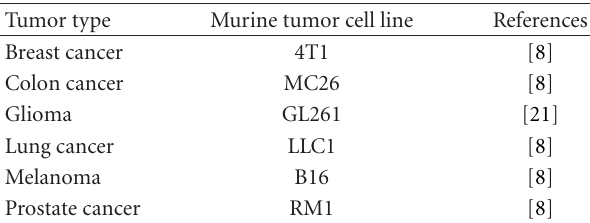
Figure 1: TLR4/MD-2 receptor complex recognizes and binds endotoxin. (a) MD-2 (shown in blue ribbons) is a soluble protein with a large hydrophobic pocket that directly binds bacterial endo- toxin (red). One of the acyl chains of endotoxin (yellow) remains outside the hydrophobic pocket and mediates crucial interactions with TLR4 that bind the TLR4/MD-2 heterodimer together. Left: direct view of the MD-2 hydrophobic pocket. Right: side view showing the protruding endotoxin acyl chain. (b) The TLR4/MD- 2/endotoxin heterodimer. Only the extracellular domains of TLR4 whose crystal structures were determined are shown [16]. Table 1: Murine tumor cell lines that express